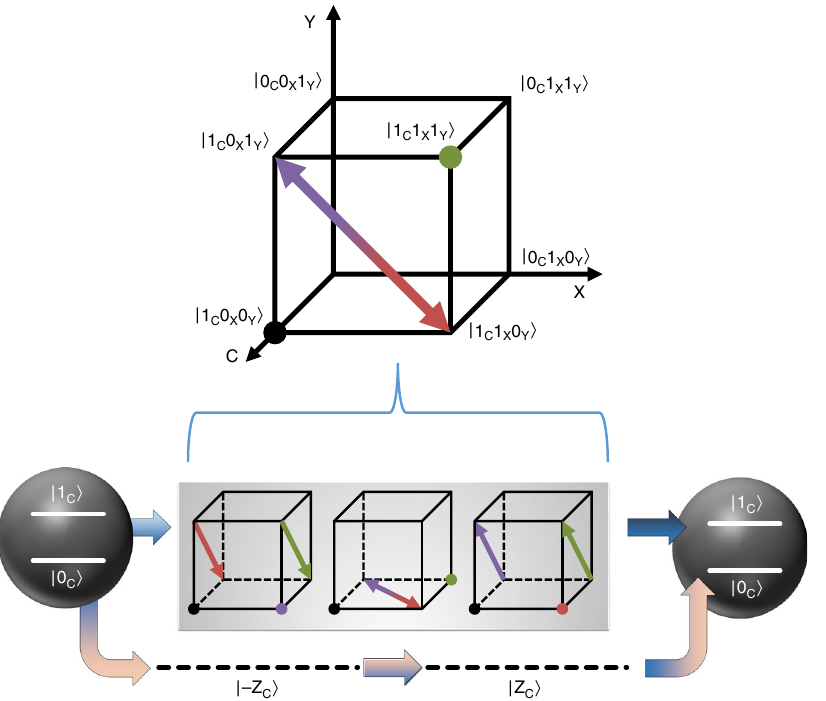
0 1 and C X Y i